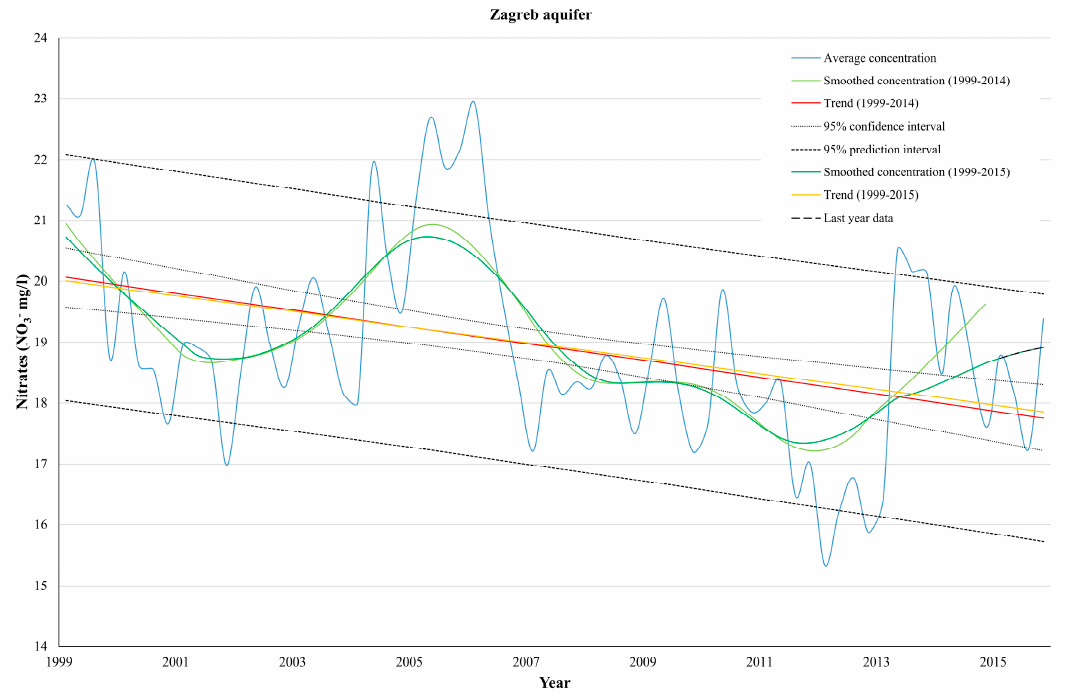
Figure 6. Trend estimation with data smoothing for the whole aquifer.